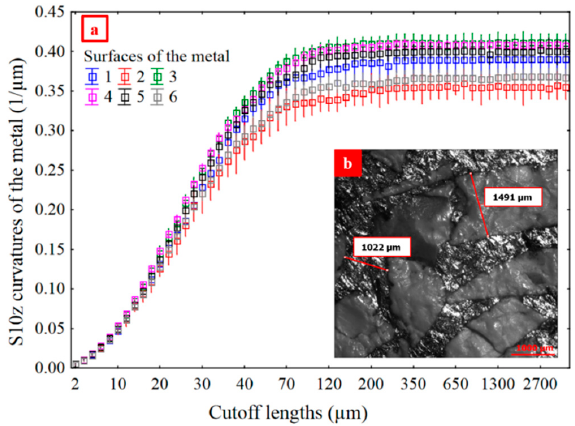
Figure 16. S10z vs. multiscale cutoff lengths for metal, mean curvatures and a high pass filtering ( a ). Common scale of the ceramic and the metal phases ( b ).